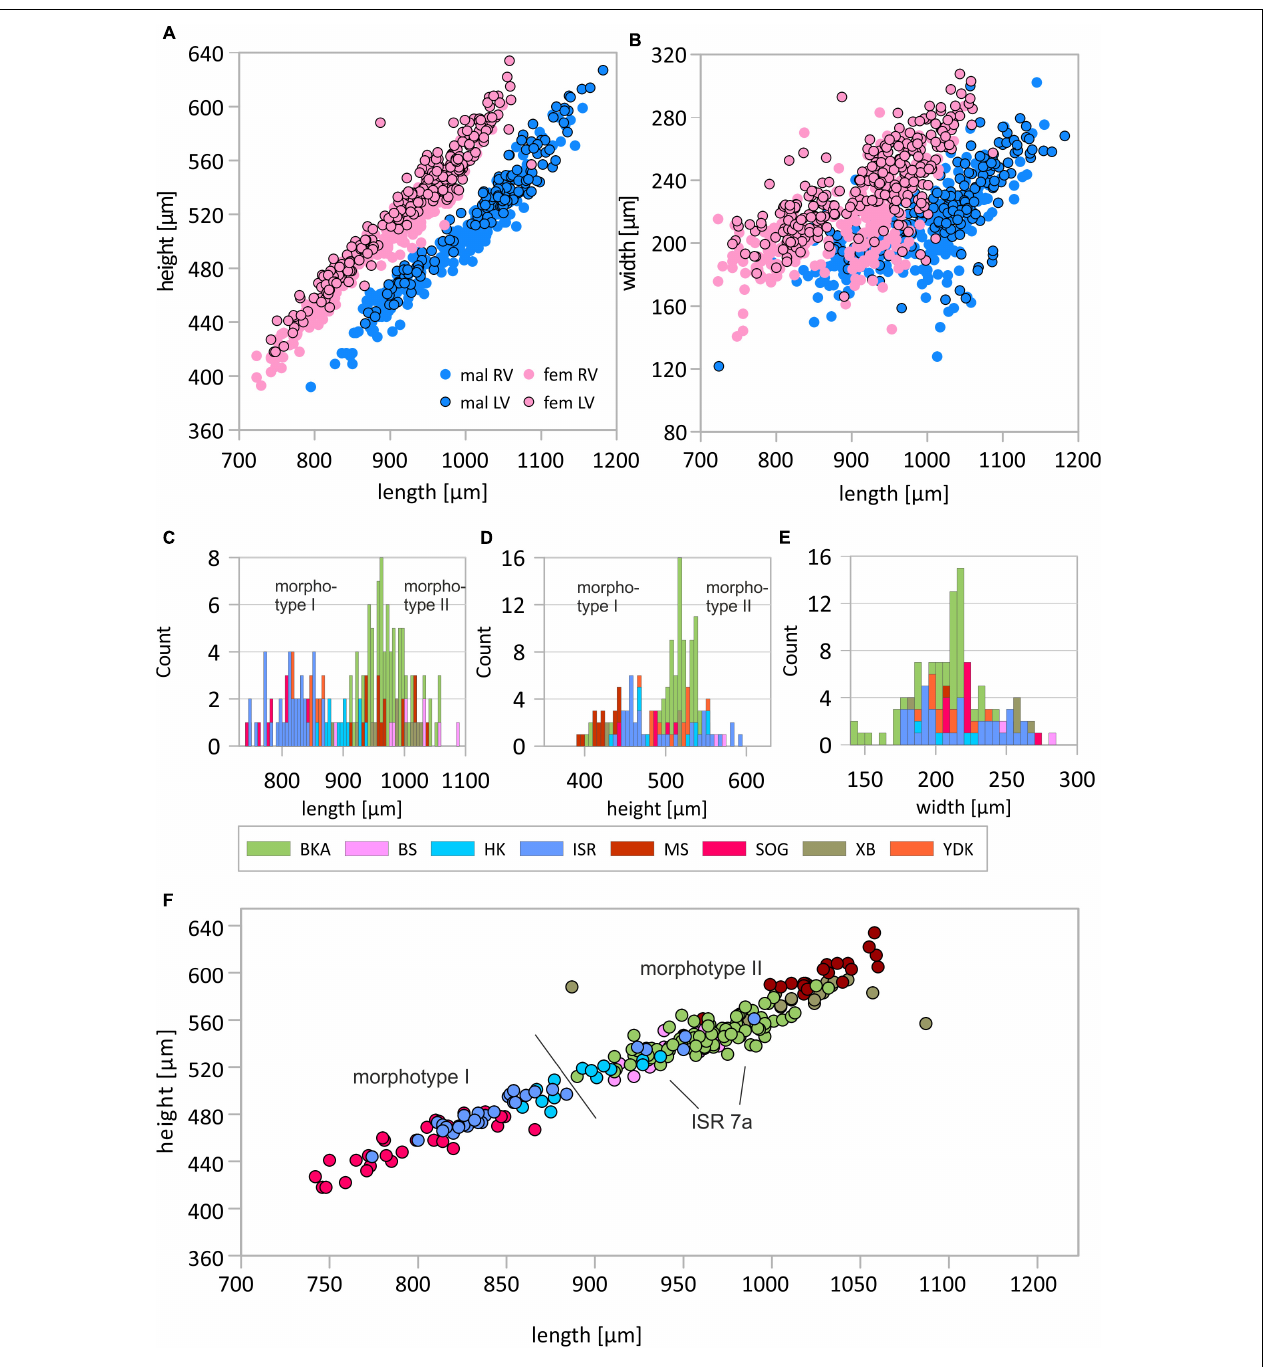
FIGURE 2 | Length-height (A) and length-width (B) plots for female and male left and right valves (LV and RV, respectively). Distribution of size data presented as histograms of valve length (C) , valve height (D) , valve width (E) , and length-height plot in which populations are indicated (F) . Population abbreviations are: YDK, Tarim Basin, China; XB, Lake Bosten, China; BKA, Lake Balkhash, Kazakhstan; ISR, Dead Sea, Israel; SOG, Sea of Galilee, Israel; BS, Danube Delta, Romania; HK, Hersek lagoon, Turkey; MS, Mansfeld Lakes, Germany. Details about the localities are provided in Table 1 . Displayed are data of female left valves, other datasets are available in the Supplementary Material